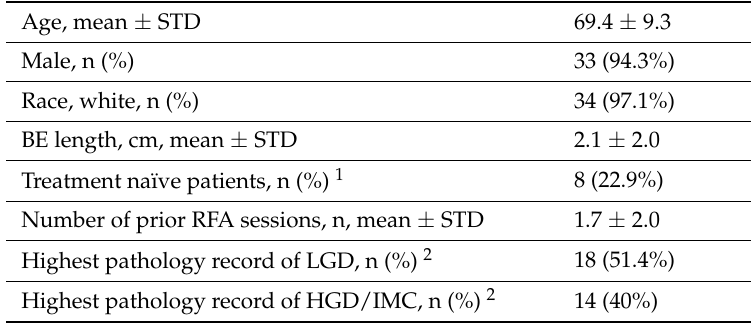
Table 1. Patient demographics (n =